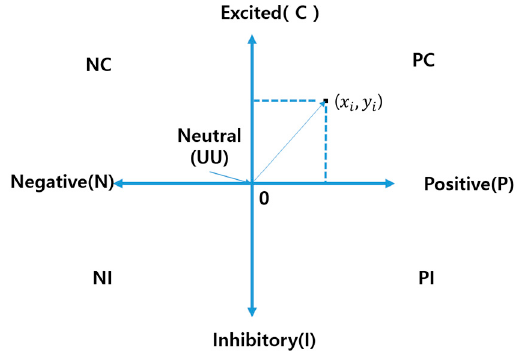
Figure 7. Energy Figure 7. Energy State.